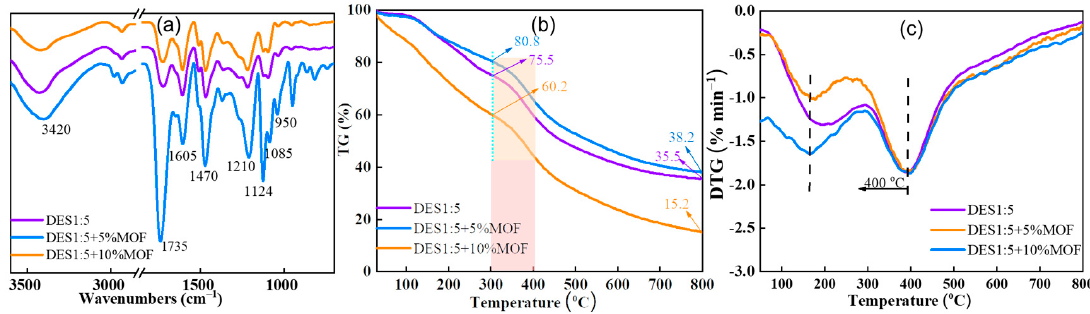
Figure 3. FTIR spectra ( a ) and TG and DTG curves ( b , c ) of the LRF cryogels at DES1:5.